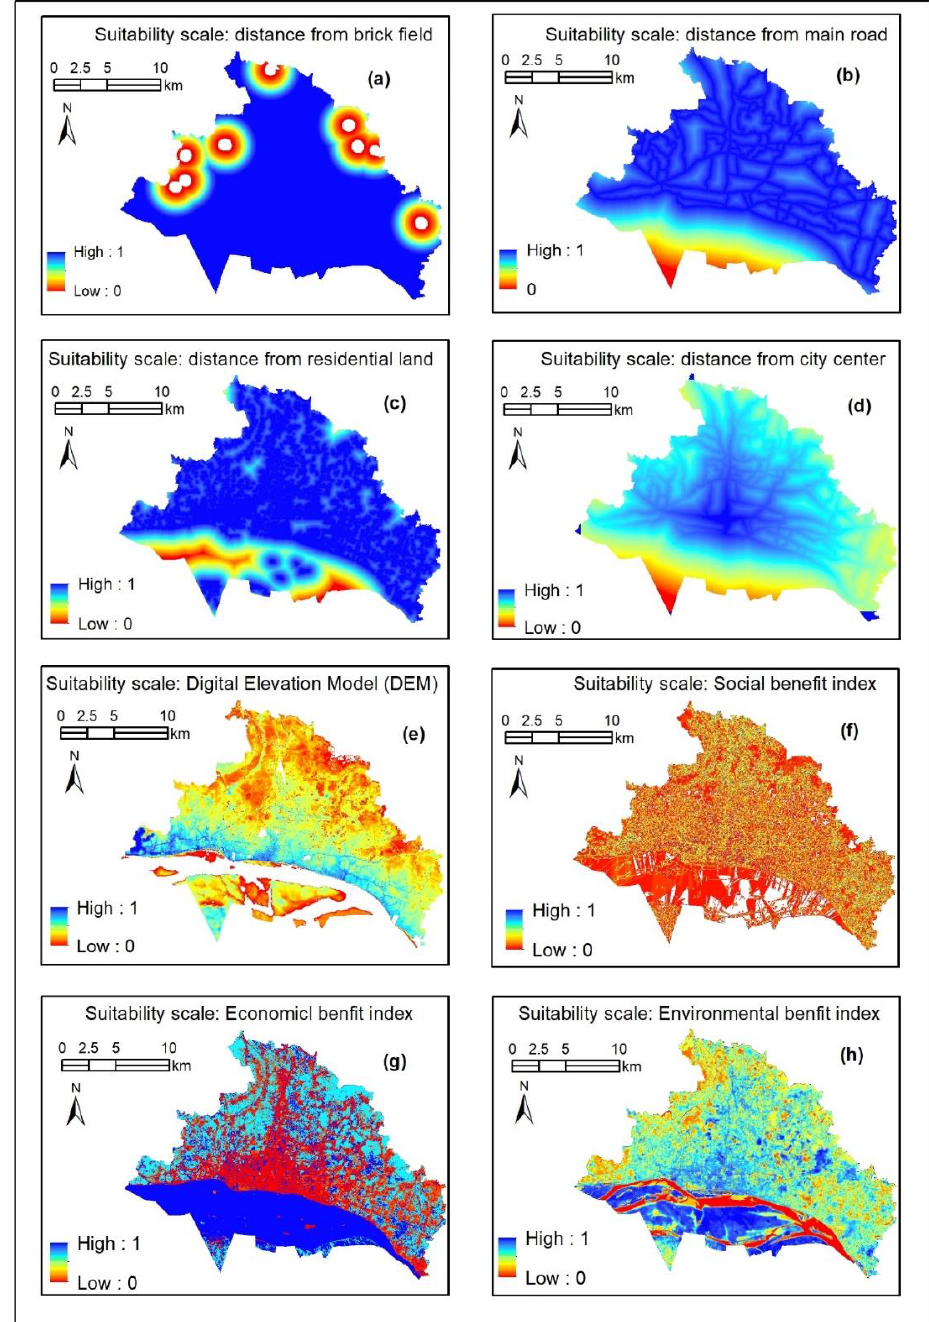
Figure 5. Residential land suitability scale (standardized value) for different factors: ( a ) distance from brick field; ( b ) distance from main road; ( c ) distance from residential land; ( d ) distance from city center; ( e ) digital elevation model; ( f ) social benefit index; ( g ) economic benefit index; ( h ) environmental benefit index.